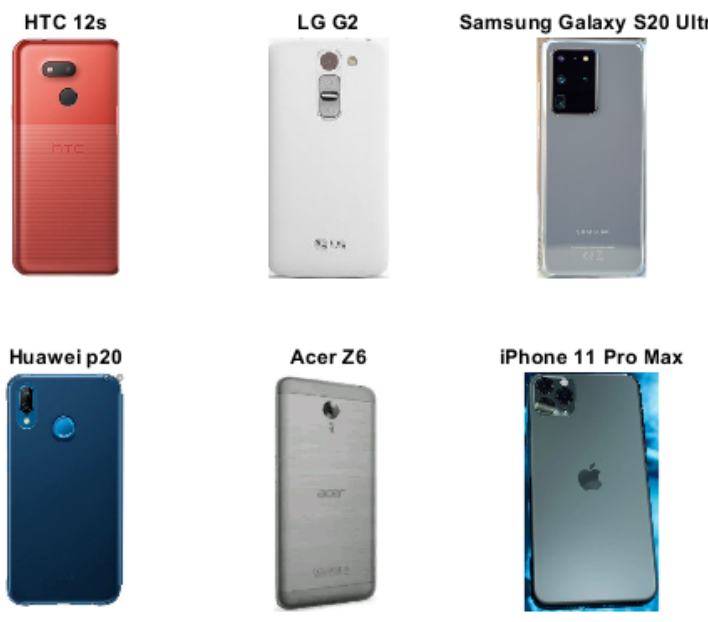
Figure 2. Example of a subset of the smartphone